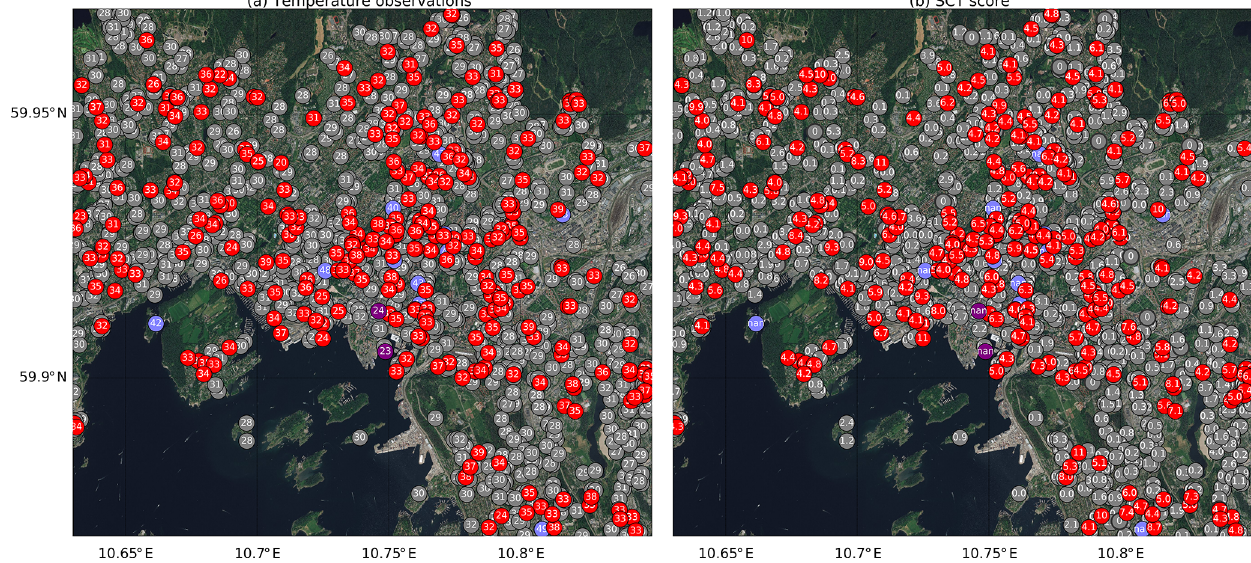
Figure 3. The result of the quality control by Titan for observations in Oslo for 12:00UTC on 28 July 2019, showing the temperature observations (a) with the corresponding SCT scores (b) . The observations passing the quality control are shown in grey, whereas those failing the plausibility check, the DEM check, or the SCT are shown in light purple, dark purple, and red, respectively. Background image source: ESRI World